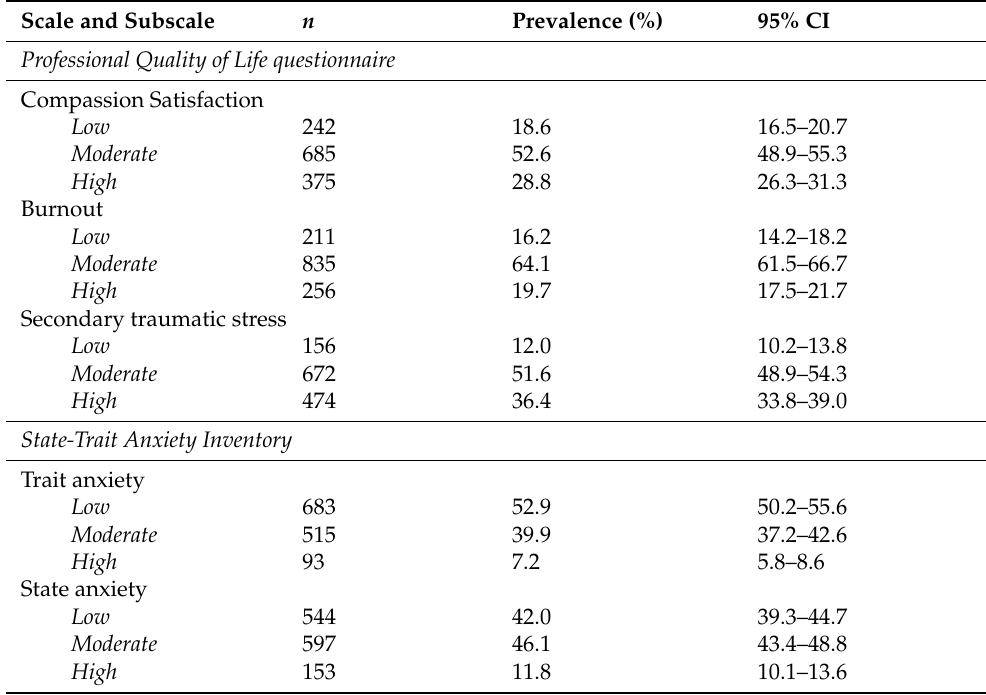
Table 2. Prevalence and severity of professional quality of life